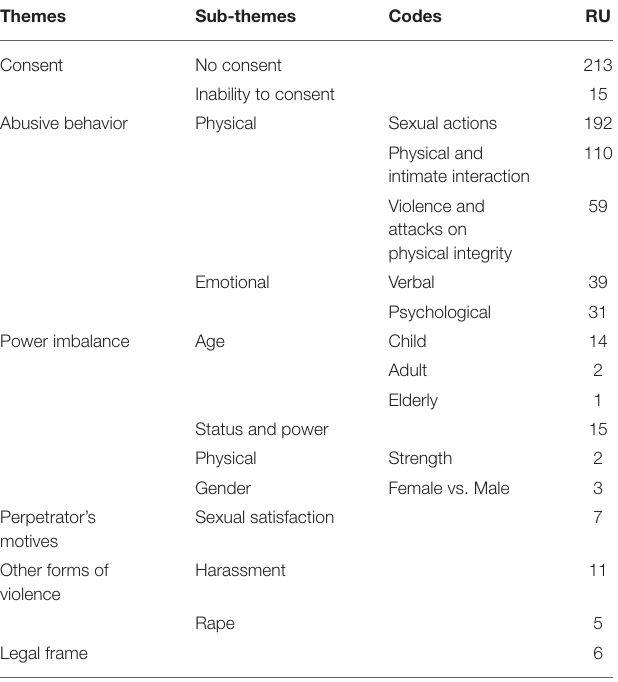
TABLE 2 | Sexual abuse themes and